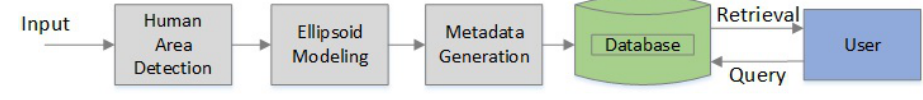
Figure 1. Block diagram of the proposed human retrieval